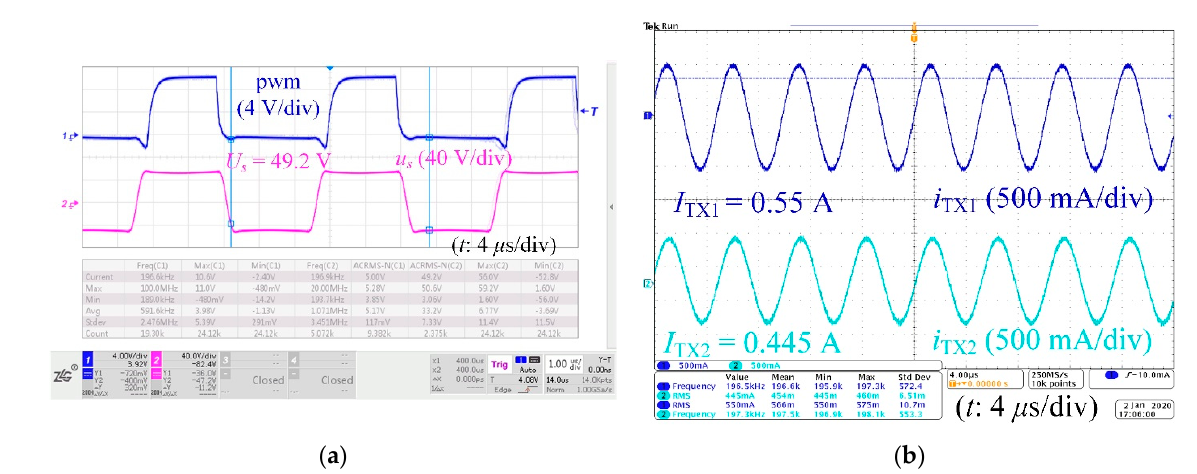
Figure 13. As h = 37 cm, m = n = 3, ( a ) the input voltage Us ; ( b ) the currents in the TX1 and TX2.